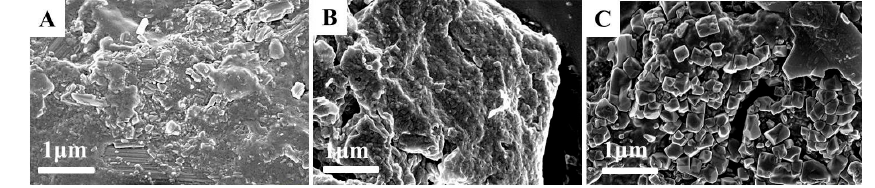
Figure 5. SEM images of NG1 ( A ); NG2 ( B ) and NG3 ( C ).